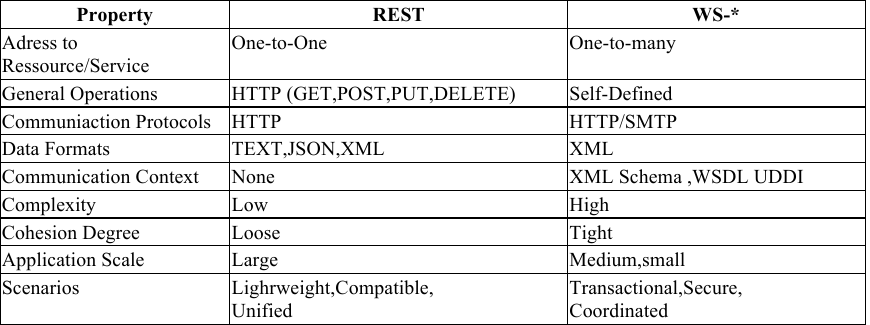
Table 1. Comparative between REST and